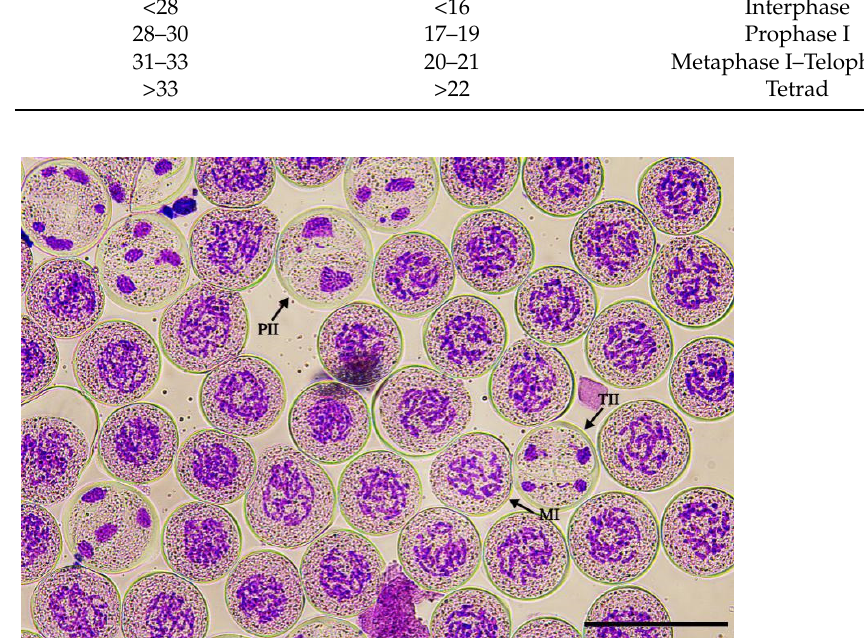
Figure 2. A mixture of meiotic stages in one flower bud. Arrows show M I (metaphase I), P II (Prophase II), and T II (Telophase II). (Bar = 100 µm).